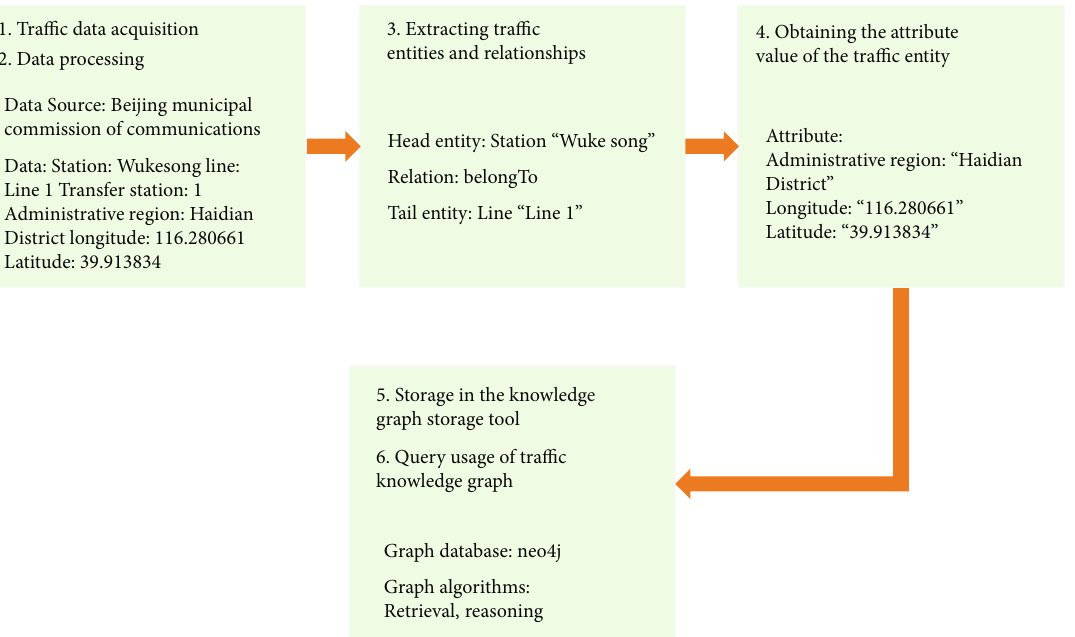
Figure 1: Knowledge graph construction process (take “ station-belongTo-line ” as an example).